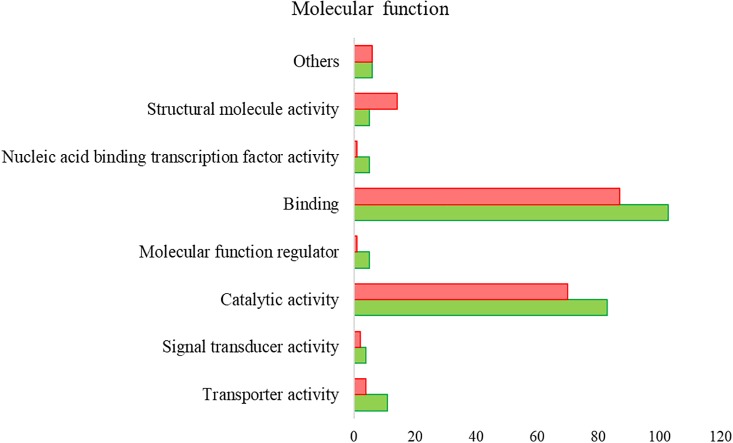
Gene ontology of the proteins from R. annulatus in response to B. bigemina infection. GO terms and its representation of MF (level 2). Green bars show over-represented proteins and red bars under-represented proteins with statistical significance (p < 0.05).